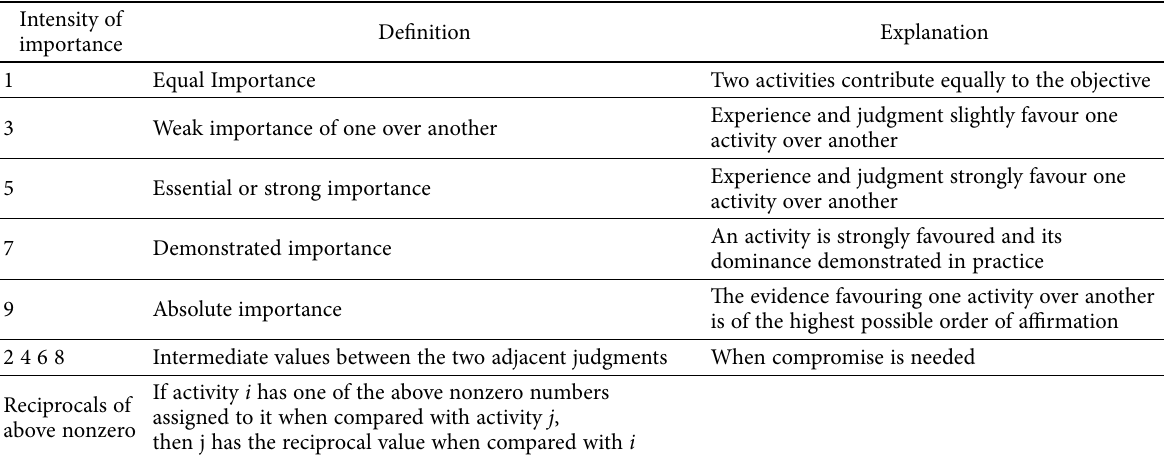
Table 1. Scale of relative importance (according to Saaty